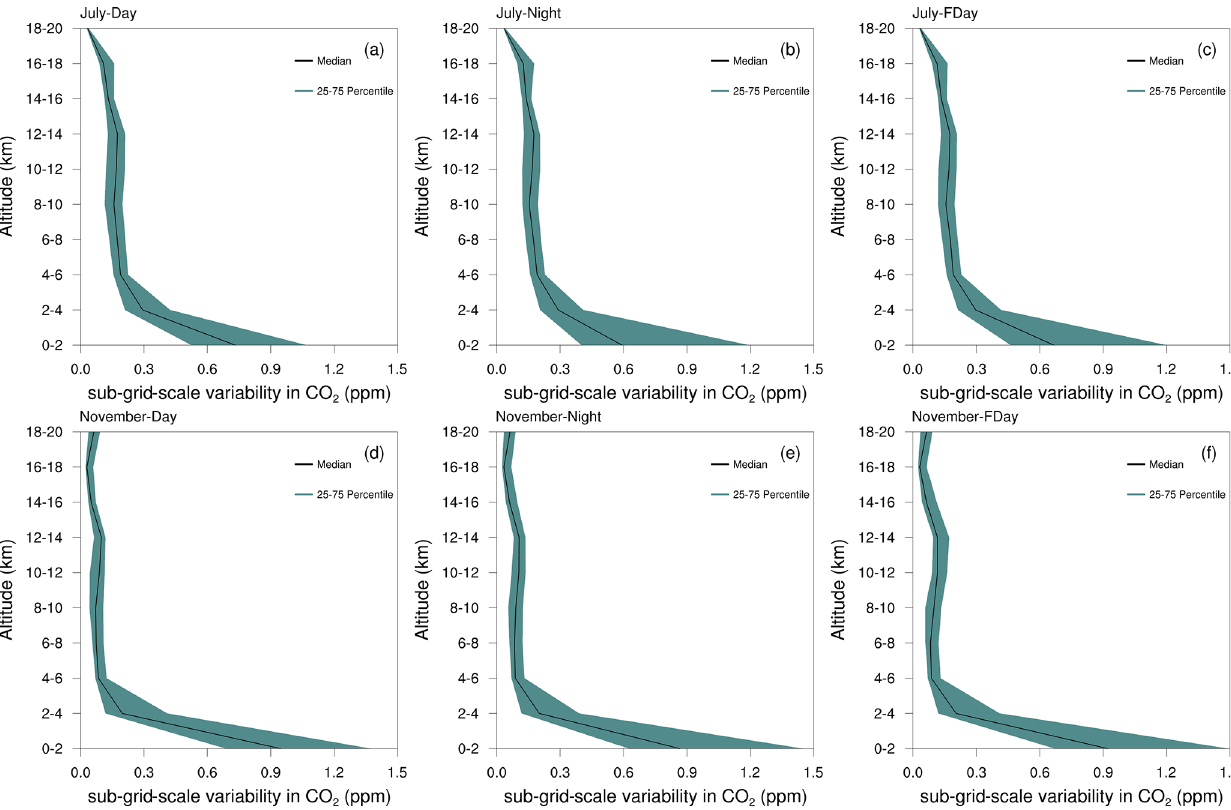
Figure 8. Variability in the representation error over India with altitude for July and November 2017. (a) July daytime, (b) July nighttime, (c) July full time, (d) November daytime, (e) November nighttime, and (f) November full time. Median values are plotted with black curves, and the shaded region indicate the 25th to 75th percentiles of